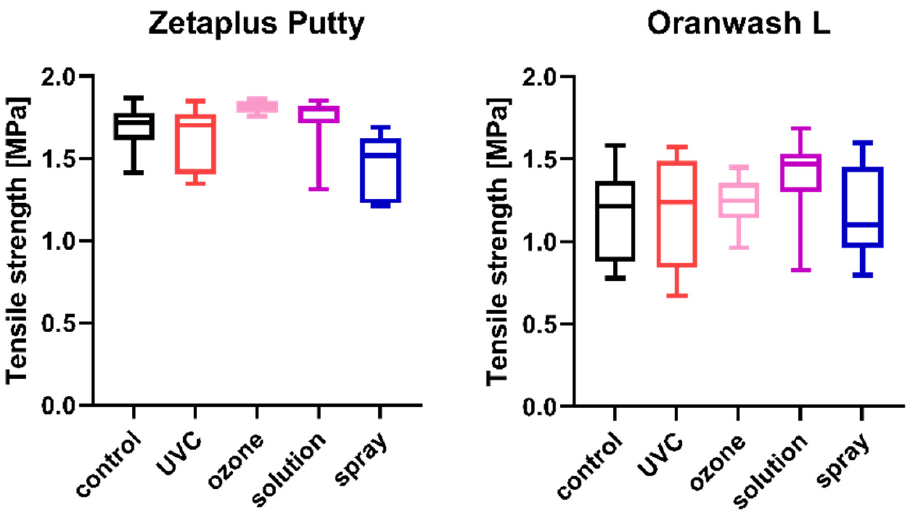
Figure 3. Tensile strength of C-silicones (Zetaplus Putty and Oranwash L) after disinfection using various